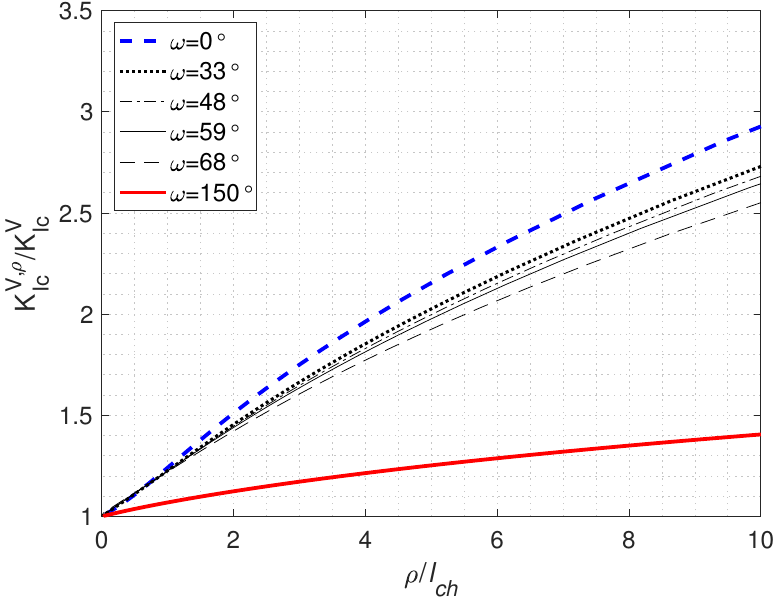
Figure 3. Dimensionless apparent generalized fracture toughness versus dimensionless notch root radius for the opening angles of the nano-cantilever considered in Section 2.2. For the sake of clarity, two additional opening angles are added as references, i.e., ω = 0 ◦ and ω = 150 ◦ . Irwin’s length l ch = ( K Ic / σ u ) 2 ≈ 5.18